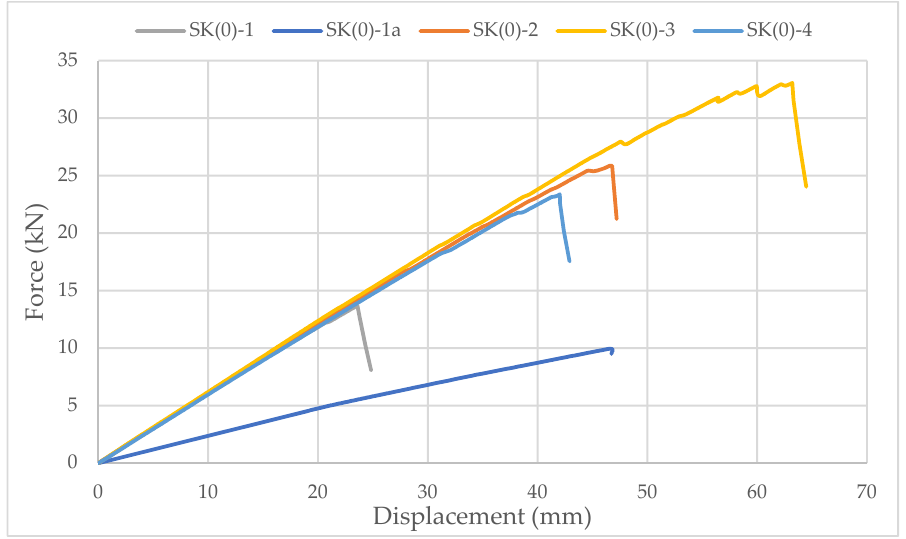
Figure 14. Force-displacement curve for strong-axis bending of samples with circular cavities.